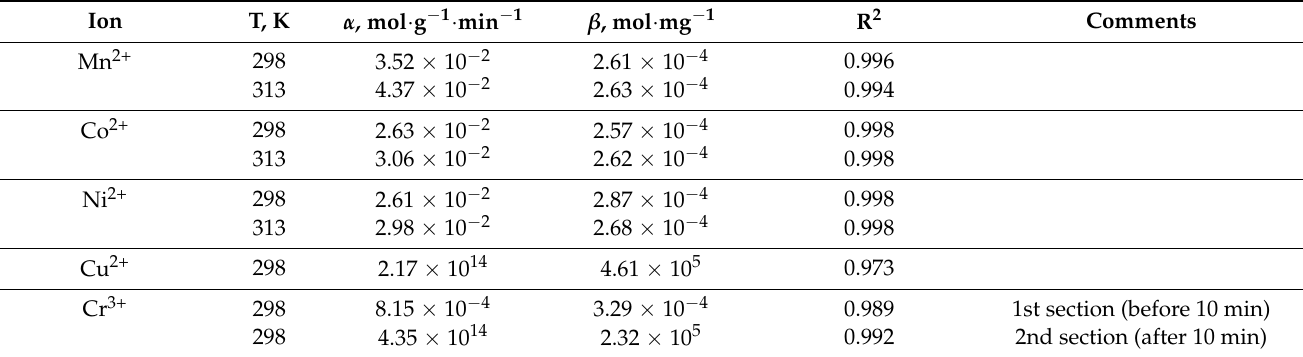
Table 3. Kinetic parameters of the Elovich model for sorption of studied ions on Li-TiOP sorbent at different temperatures.